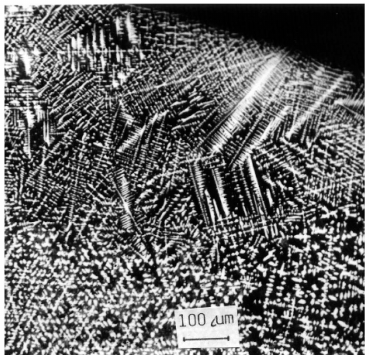
Figure 12. Cast structure of hardfacing weld E 518 B.